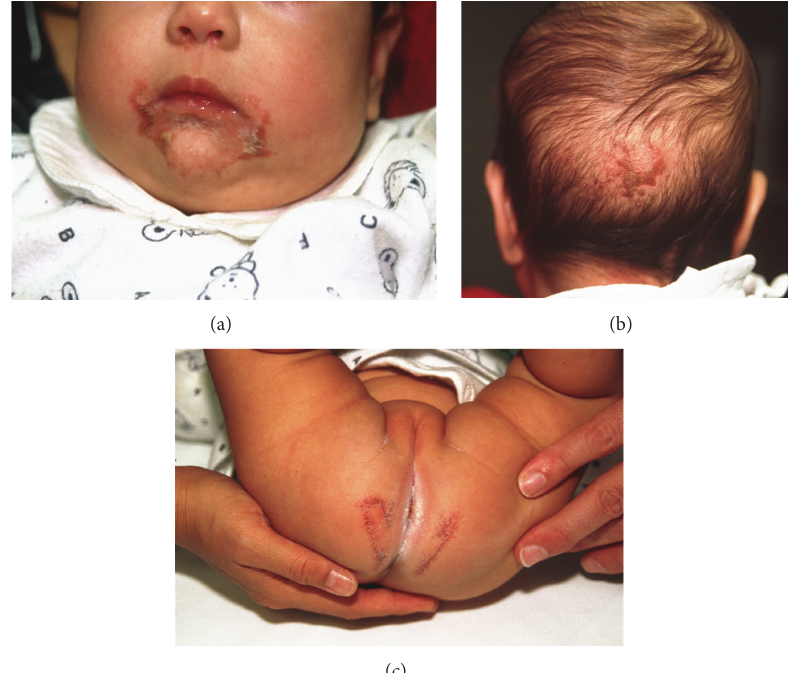
Figure 2: Skin lesions . Skin lesions in a perioral region (a), on the head (b), and in the anal region